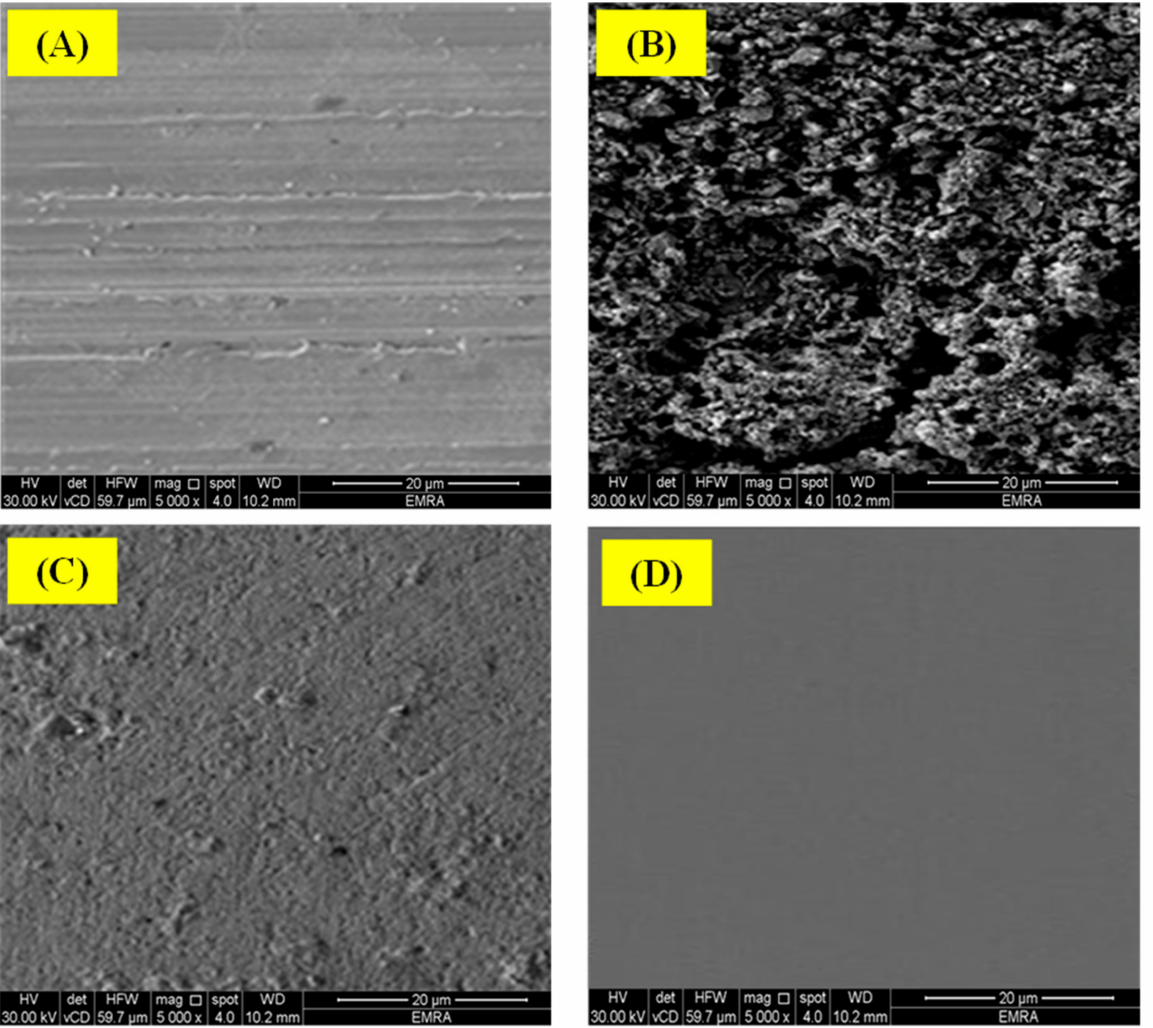
Figure 12. FE-SEM images of the pristine duplex steel ( A ) substrates after 24 h dipping in blank 2.0 M H 2 SO 4 solutions without ( B ) and with of 200 ppm CH polymer ( C ) and CH/Zn@H 3 BTC composite ( D